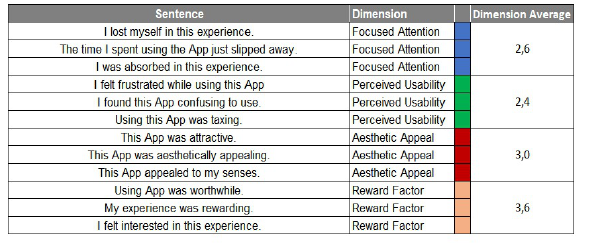
Figure 13. UES Results ­ Remote Interaction